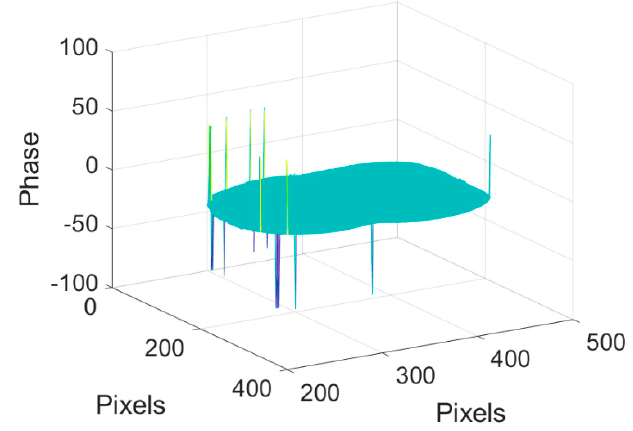
Figure 9. The error of the 3D reconstruction of Figure 8.